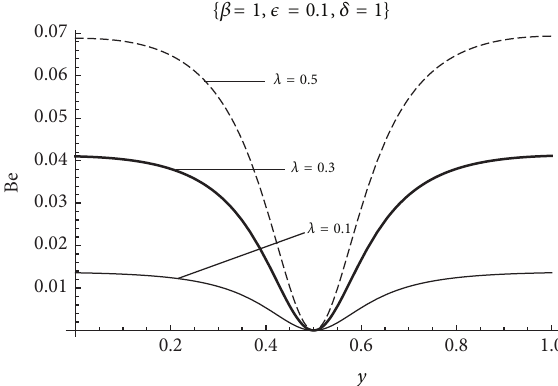
Figure 3: Entropy generation rate for different Frank-Kamenetskii parameter.